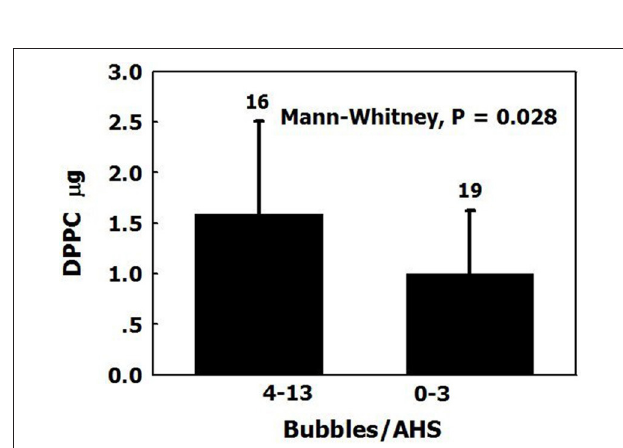
FIGURE 7 | DPPC on blood vessels. The amount of DPPC (mean ± SD ) in AHS which produced more than four bubbles over 30 min, compared with those which produced < 4 bubbles and control samples (adapted from Arieli et al., 2016 with permission).